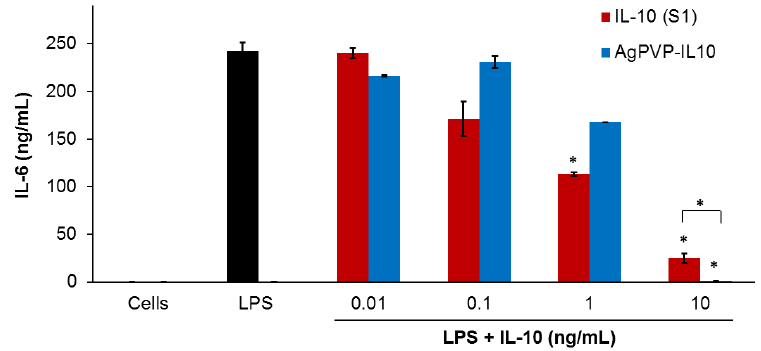
Figure 5. The effect of free rmIL-10 and rmIL-10 conjugated Ag-PVPs on the production of IL-6 by mouse J774 macrophages stimulated with lipopolysaccharide (LPS). Cells (10 6 cells/mL) were stimulated with LPS (1 μg/mL) and treated with different concentrations of either free rmIL-10 (fresh, S1) or rmIL10-conjugated Ag-PVPs (stored one week at 4 °C). Cell-free culture supernatants were collected at 72 h post-incubation and were used to measure the production of IL-6 by cytokine ELISA. Untreated and LPS-stimulated cells were used as positive controls, and untreated and non-stimulated cells were used as negative controls. * indicates a significant difference ( p < 0.01) between the untreated and LPS-stimulated cells versus LPS-stimulated and treated cells as calculated by the unpaired Student’s t -test. The data are presented as means and standard deviations of samples run in duplicate and are representative of three separate experiments.